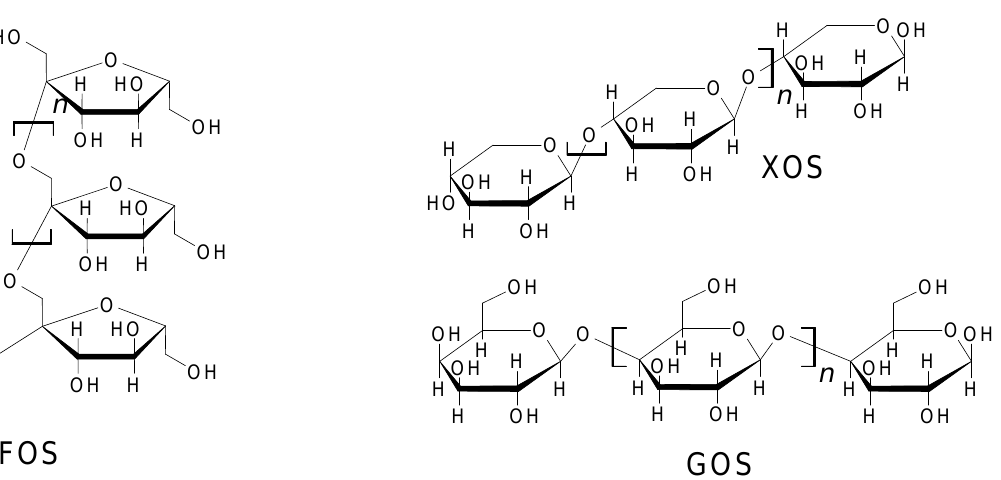
Figure 6. Molecular structures of FOS, XOS and GOS.